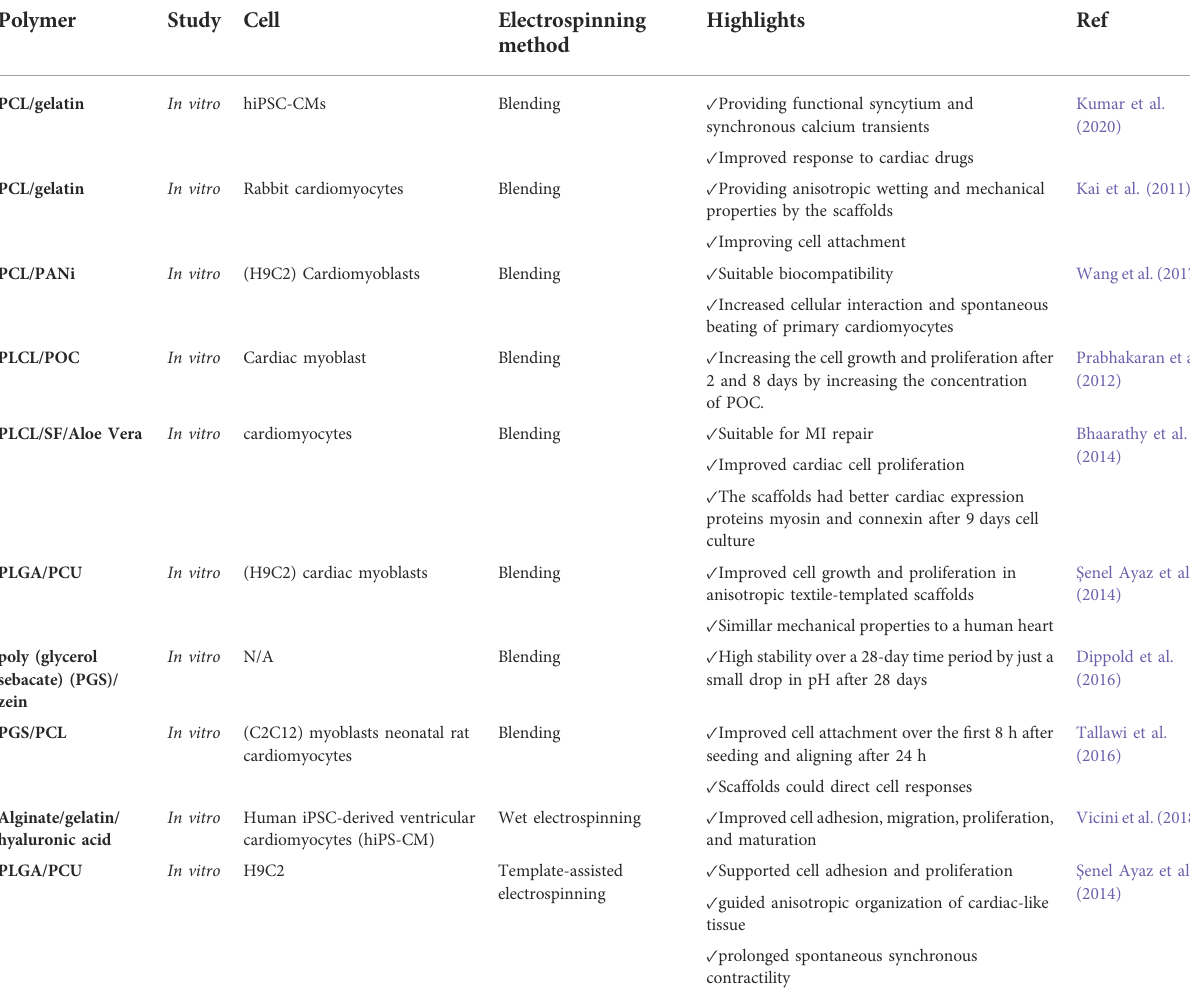
TABLE 7 An overview of electrospun hybrid nano fi ber for cardiac tissue engineering.